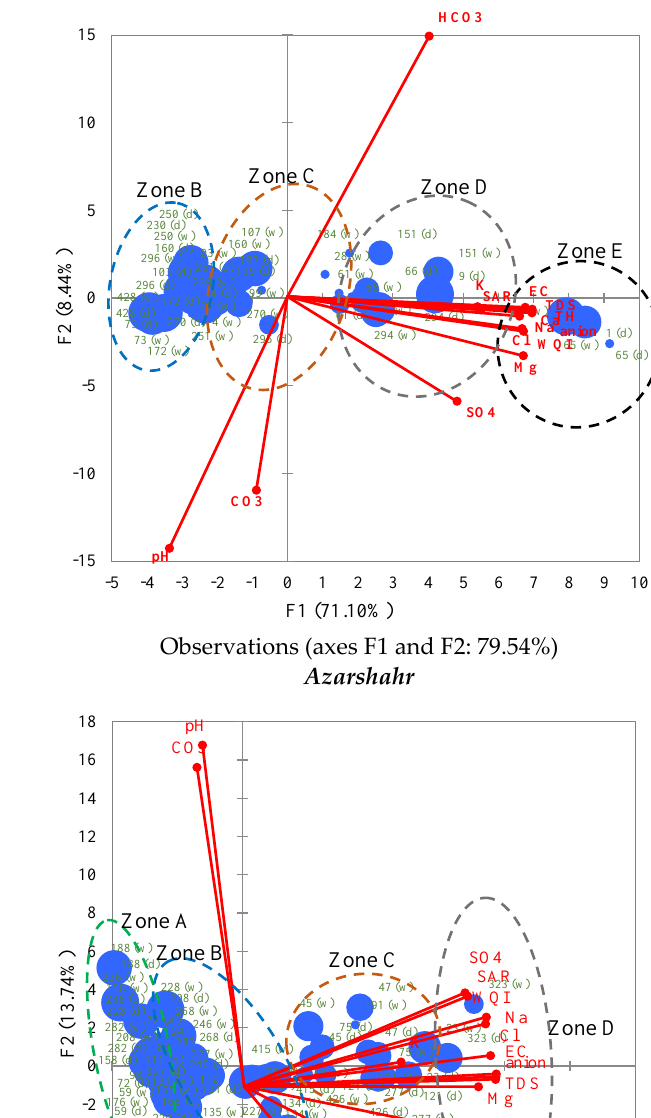
Observations (axes F1 and F2: 80.61%) Shiramin